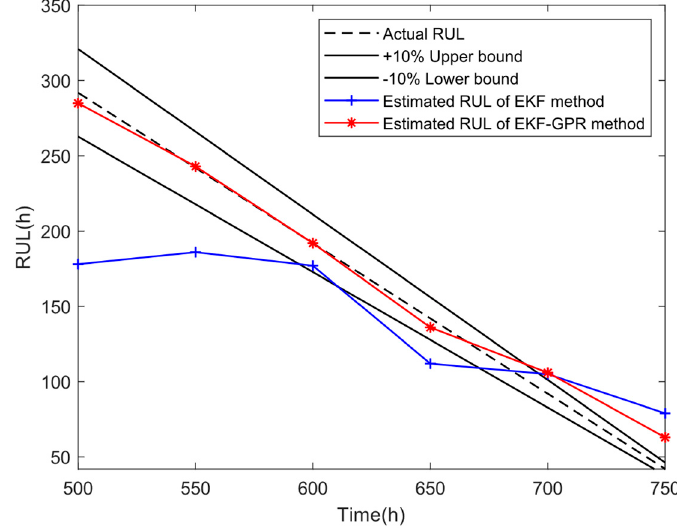
Figure 9. Comparison of EKF-GPR method and EKF method of RUL prediction performance.